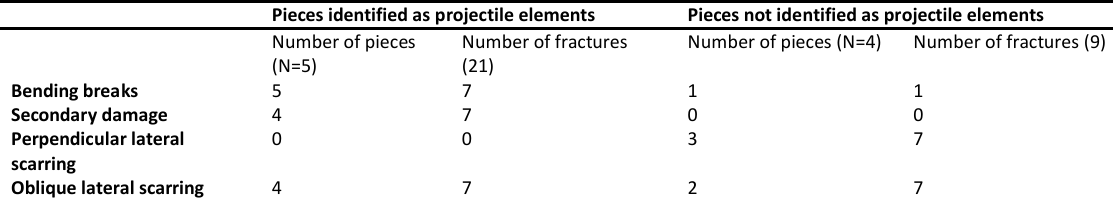
Table 10 . Overview of the occurrence of the four ractures categories within the curved backed point sample of locus